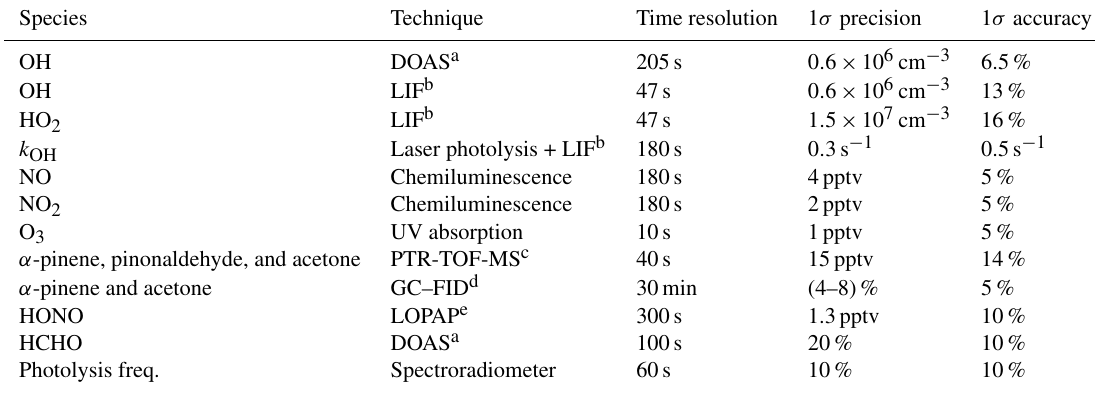
Table 1. Instrumentation for radical and trace-gas measurements.